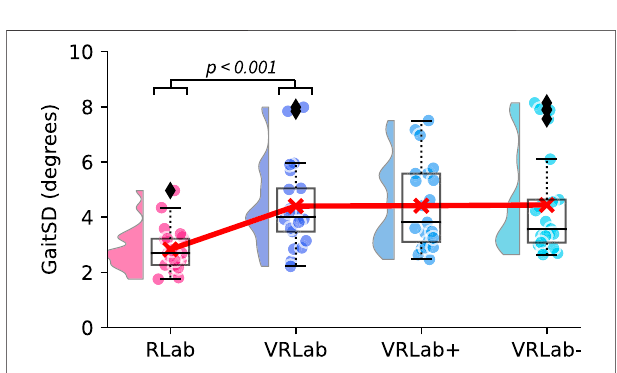
FIGURE 4 | Gait variability in terms of GaitSD during walking in the real lab (RLab), the virtual lab (VRLab), the over-sized (VRlab+), and down-sized (VRLab − ) lab. The plot shows the data distribution (probability density function), the jittered raw data, the mean (red line), and a box plot showing quartiles where whiskers extend to the end of the data distribution except for outliers (diamonds) Allen et al. (2021).